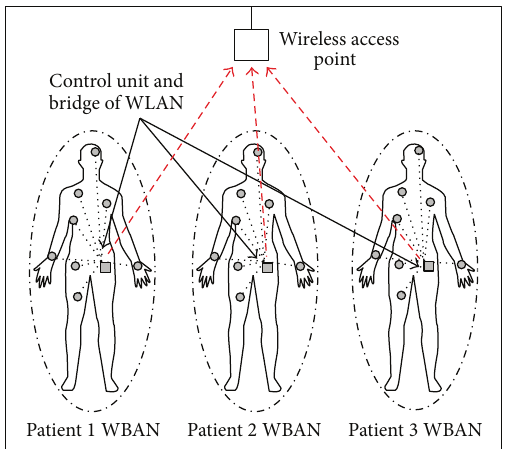
Figure 1: Structure of a simple WBAN.